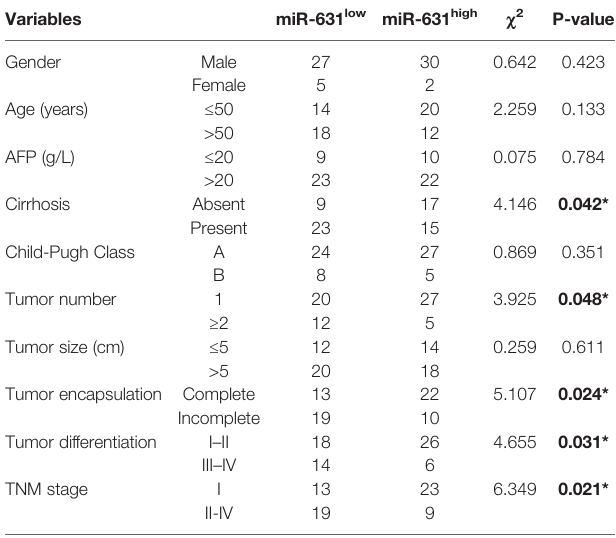
*In bold: The value is statistically signi fi